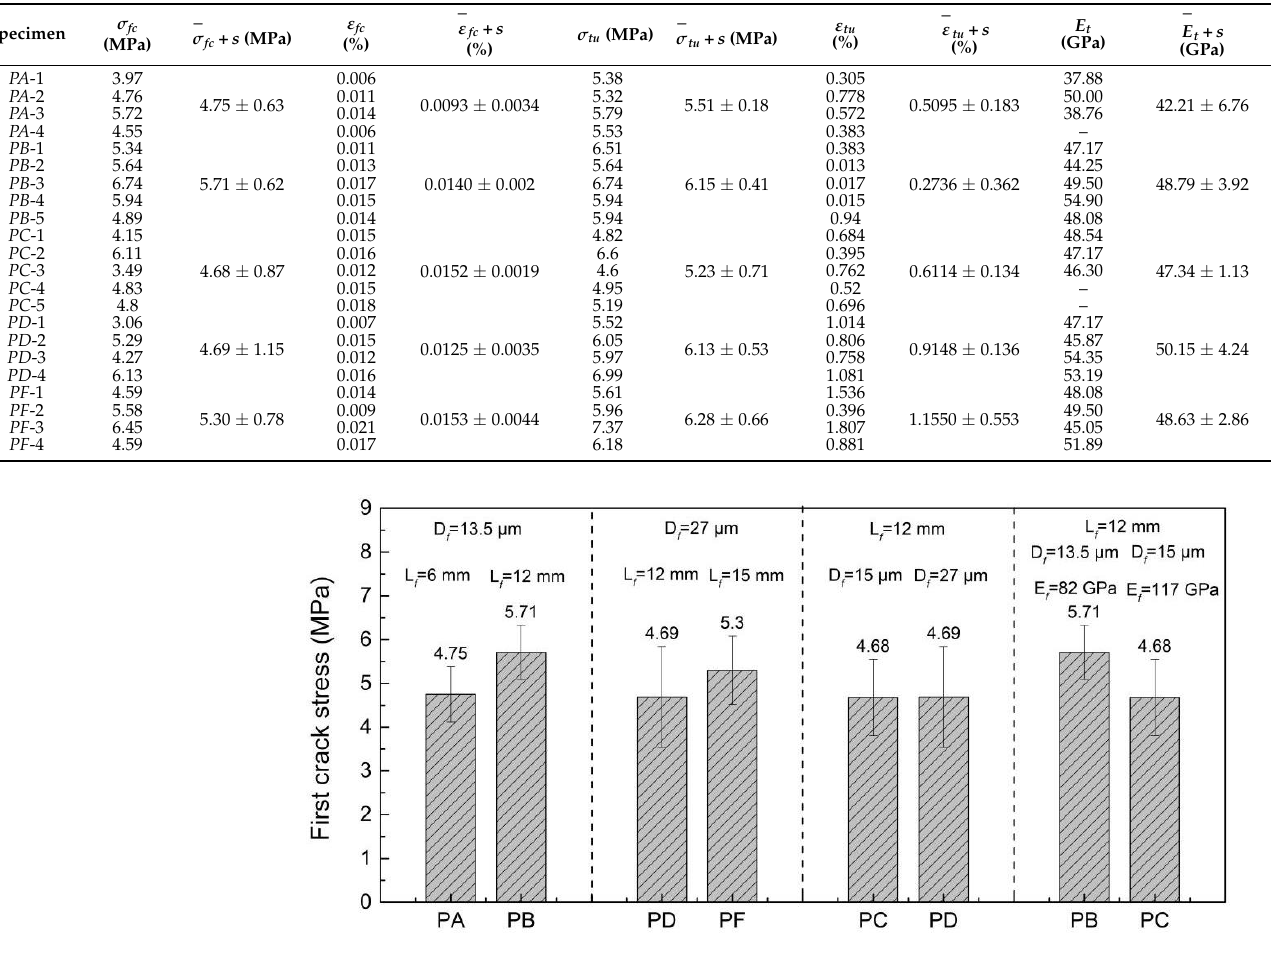
Figure 6 . First crack strength of PE fiber-reinforced UHPC.